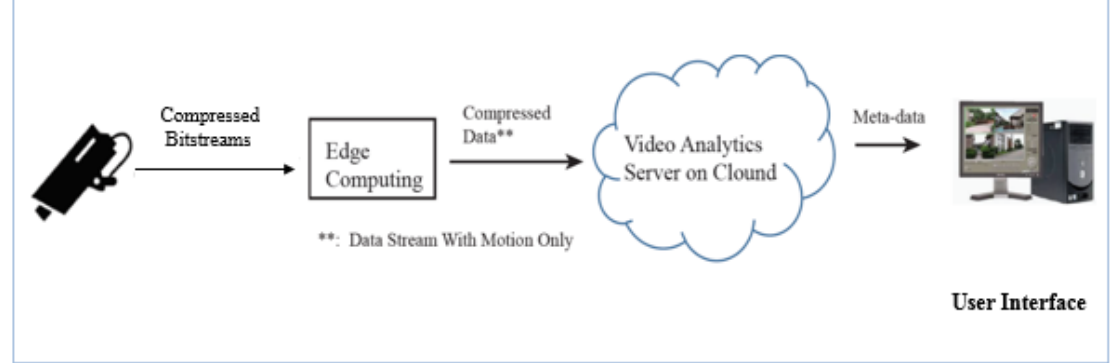
Figure 5. Overview of the proposed edge-to-cloud system